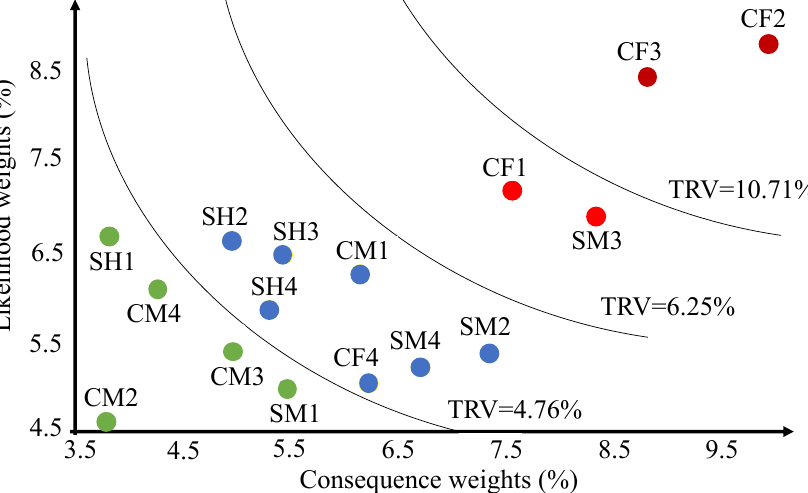
Figure 5. The risk matrix for the Taiwan ferries case.